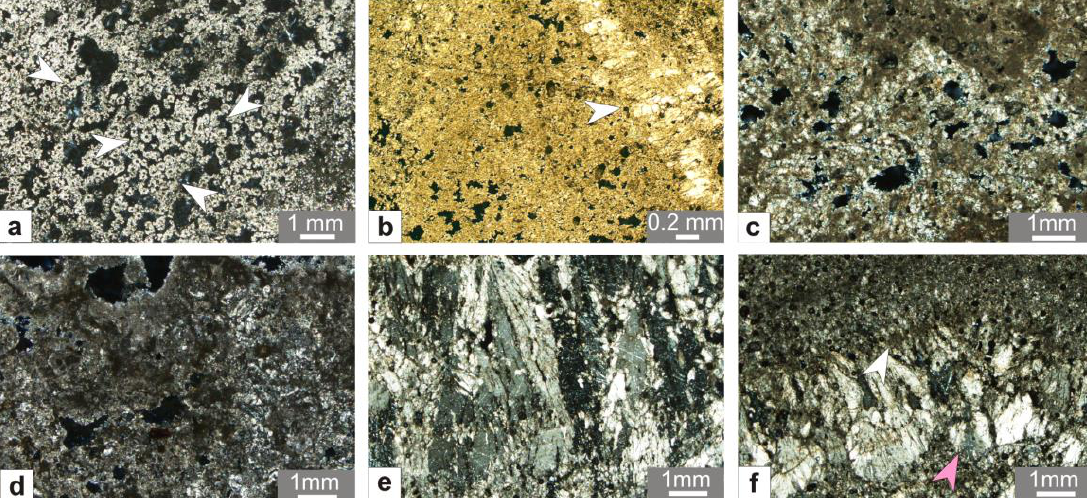
Figure 4. Optical photomicrographs of thin sections. ( a ) Algal tufa. Note regular oval-shaped voids, surrounded by spherical calcite crystals (white arrows); ( b ) Algal tufa. White arrow points to void, filled by sparry calcite crystal; ( c ) Moss tufa built by micrite and sparite; ( d ) Phytoclastic tufa dominantly built by micrite; ( e ) Fan-shaped sparry calcite crystals in stromatolitic laminated tufa; ( f ) Micritic laminae (white arrow) alternates with sparitic laminae (pink arrow) in stromatolitic laminated